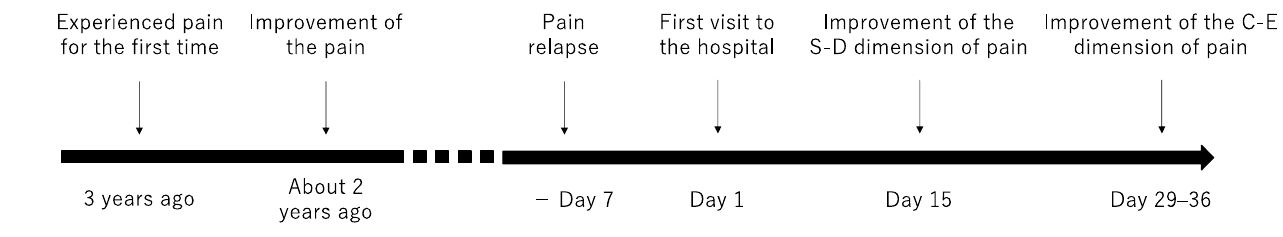
Figure 1. Progress of time points.